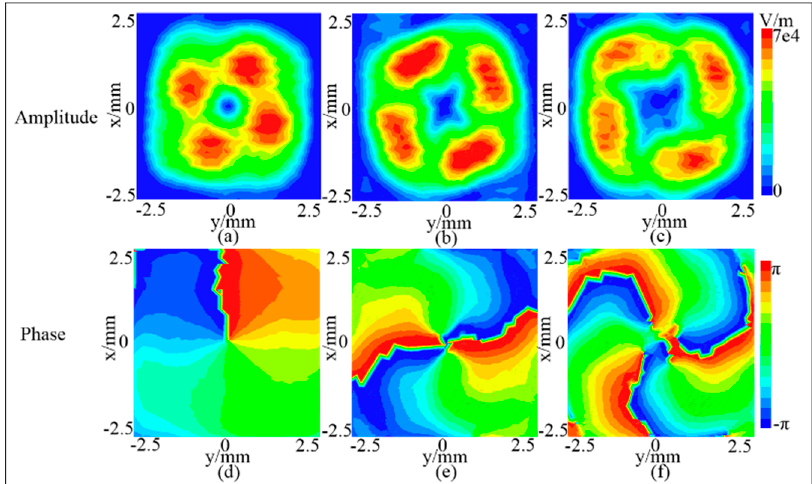
Figure 7. ( a – c ) The electric field intensity distributions and ( d – f ) the phase wavefronts of the generated OAM vortex beams with a topological charge of l = 1, 2, 3 based on the patch array with different order phase gradient.